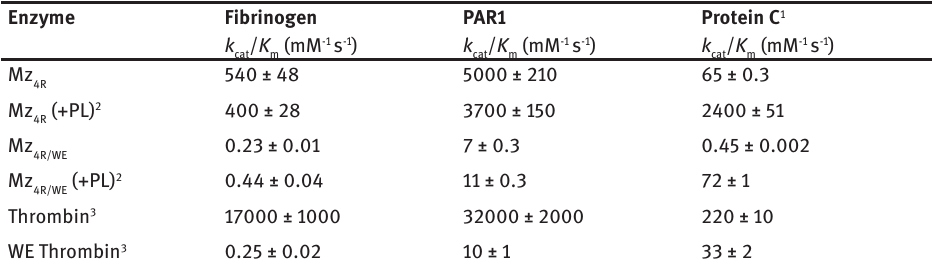
Table1: Specificity constants for the hydrolysis of natural substrates under physiological conditions. Enzyme